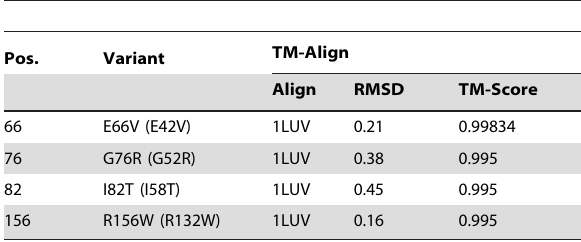
Table 3. Structure alignment comparing mutant models and wild-type SOD2